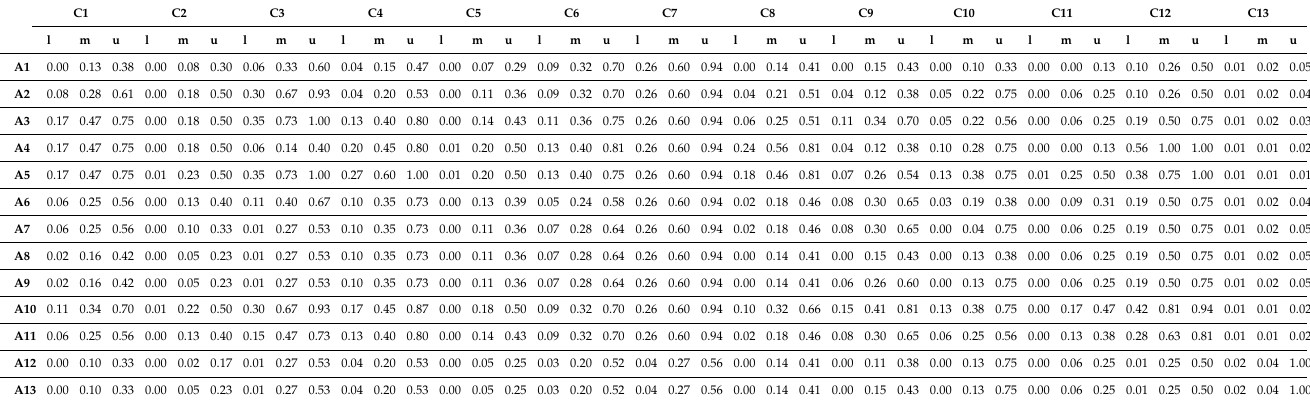
Table A8. Weighted normalized fuzzy decision